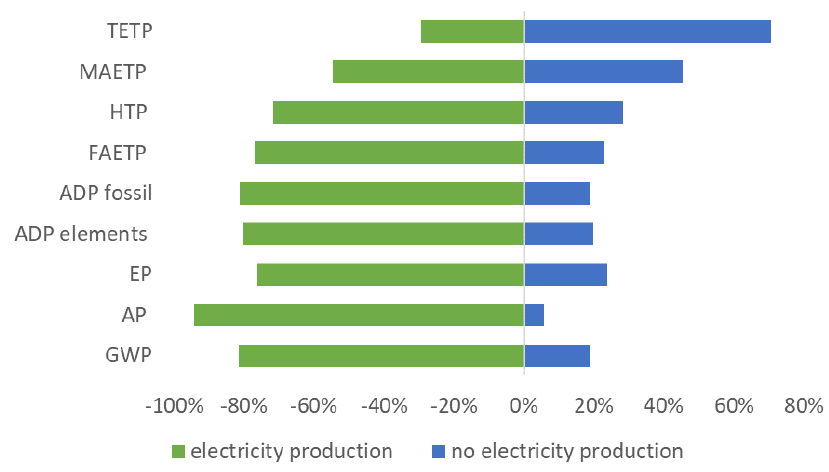
Figure 15. Electricity production and self-consumption effect on the environmental impact categories.